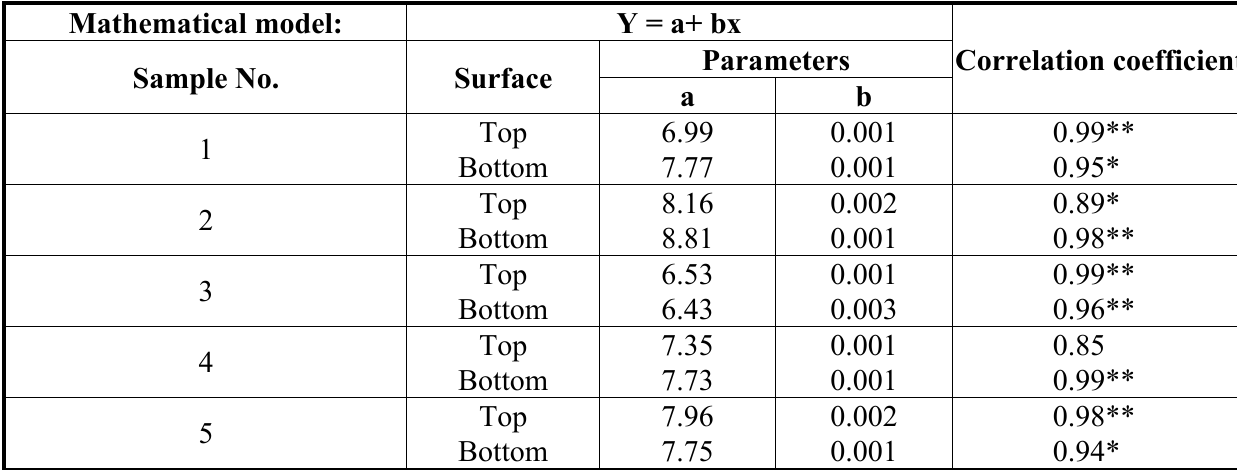
Table 2. Statistical model of the average reflectance (Y) changes for analyzed dietary chocolate samples during their storage for up to 1